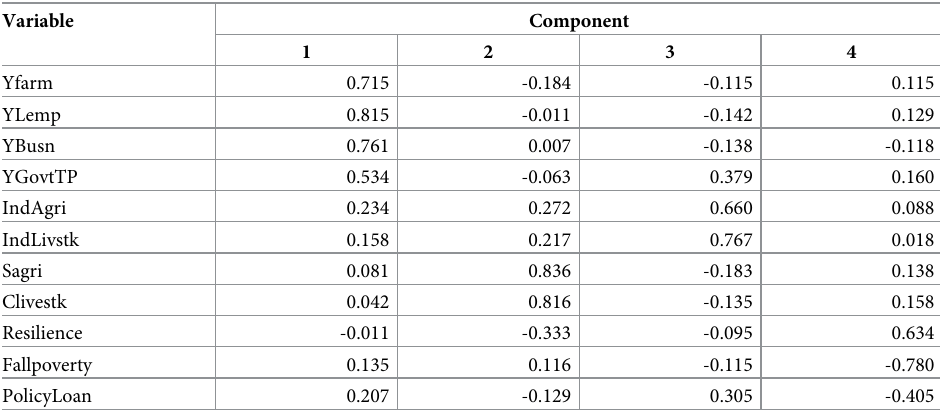
Extraction Method: Principal Component Analysis.